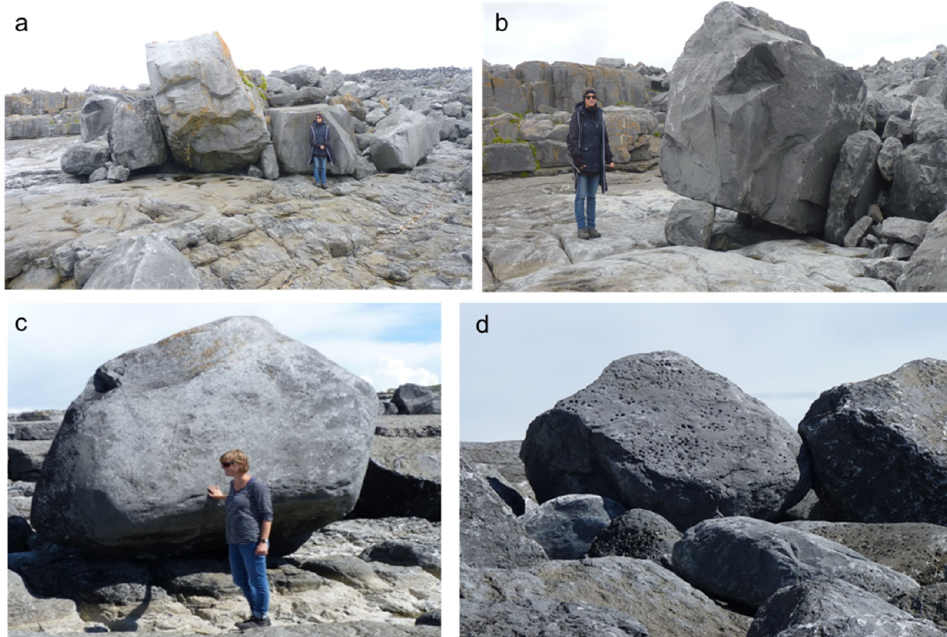
Figure 4. ( a , b ) Boulders up to 40 tons in mass, activated and partly shifted by hurricane storm waves 2013/2014 at the south coast of Inishmore; ( c , d ) rounded boulders up to 20 tons from the tidal fringe (see Lithophaga borings in ( d )) at the northwest coast of Inishmaan, where only refracted waves may impact.